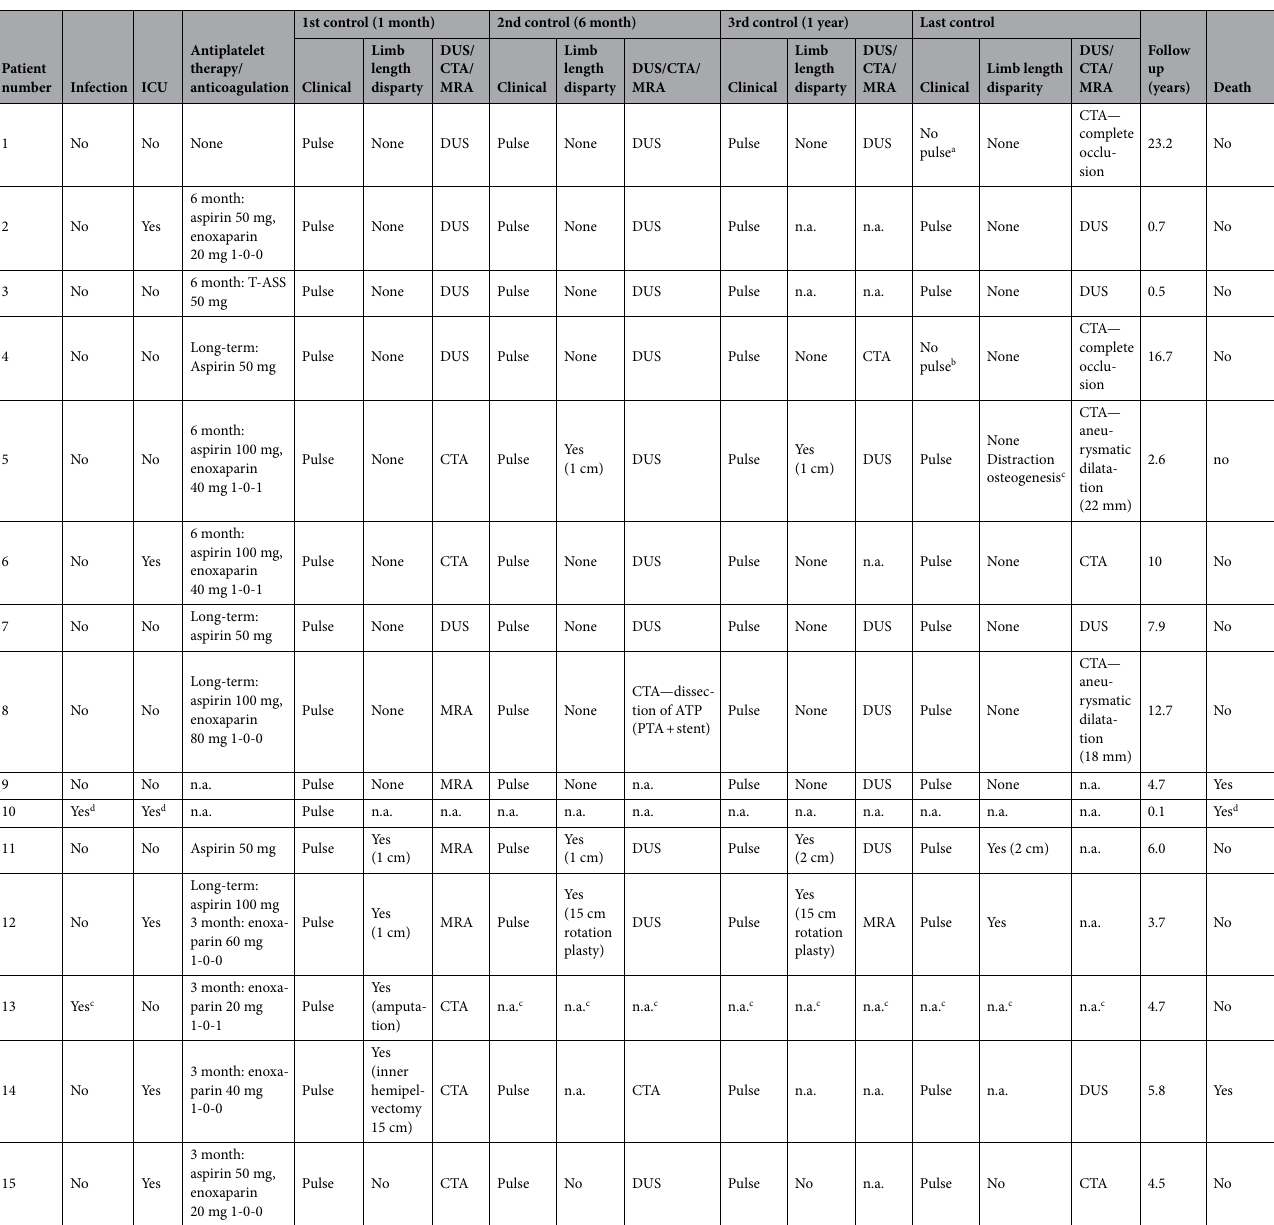
Table 3. Patient characteristics—outcome. Graft is patent by the imaging modality stated in the chart, unless otherwise noted. a Occlusion of the artificial bypass graft 12 years after surgery, with good collateralization. b Occlusion of the artificial bypass graft 16 years after surgery, with good collateralization. c Amputation due to orthopedic implant infection, 2 months after surgery. d Death due to septic